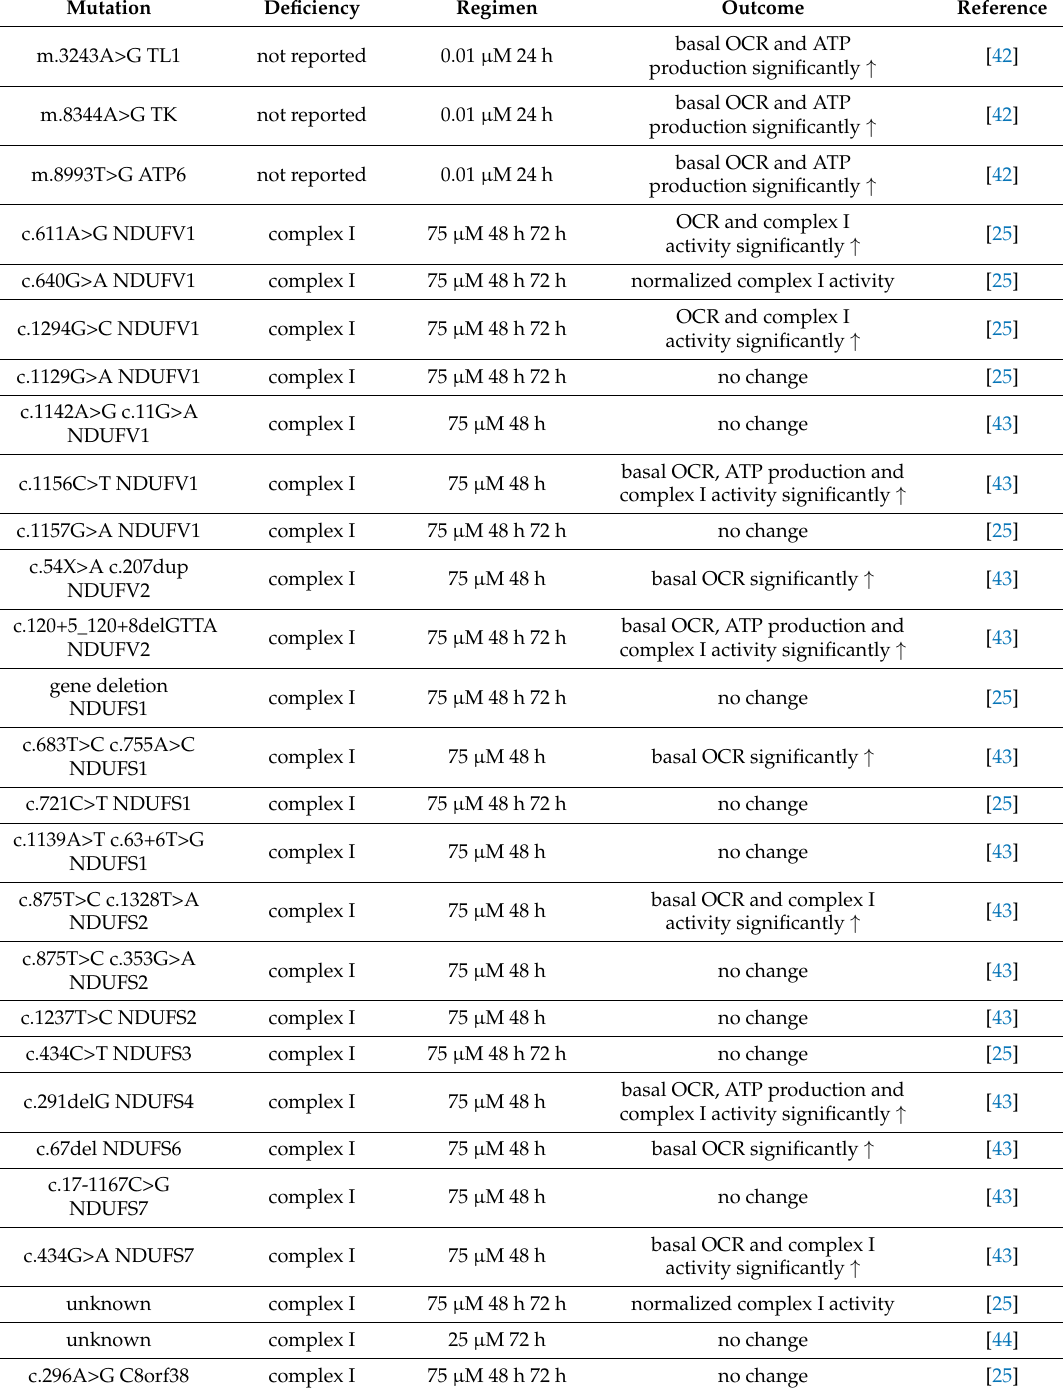
Table 1. In vitro results of resveratrol treatment outcome in cultured skin fibroblasts from patients with oxidative phosphorylation